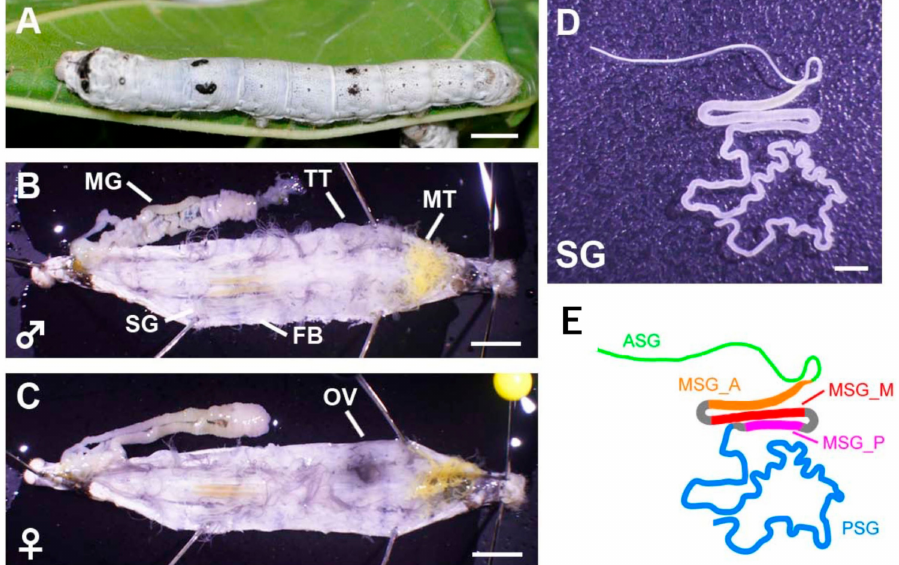
Figure 2. Tissues used in this study. ( A ) Final (fifth) instar larva of the silkworm p50T (daizo) strain. Scale bar = 5 mm. ( B , C ) Male ( B ) or ( C ) female individuals dissected on the third day of fifth instar larvae. Scale bar = 5 mm. MG—mid gut; TT—testis; MT—Malpighian tubules; SG—silk gland; FB—fat body; OV—ovary. ( D , E ) Image ( D ) and schematic ( E ) of the silk gland. ASG—anterior silk gland; MSG_A— anterior part of the middle silk gland; MSG_M—middle part of the middle silk gland; MSG_P—posterior part of the middle silk gland; PSG—posterior silk gland. Scale bar = 2.5 mm.